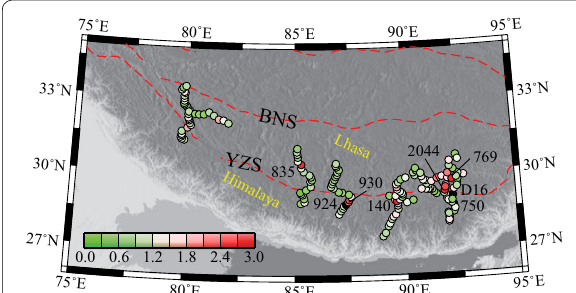
Fig. 3 The site by site r.m.s. misfit distribution in the study area after final iteration using ModEM. The circles delineate the MT stations whereas the filled color shows the value of the r.m.s. The dashed red lines show sutures, YZS and